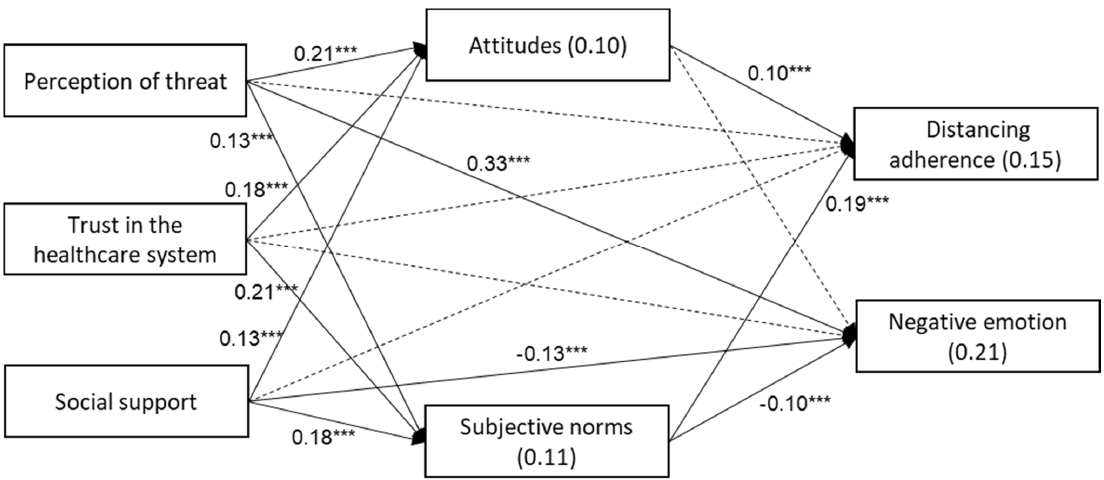
Figure 1. Path analysis for the perception of threat, trust in the healthcare system, social support, attitudes, and subjective norms towards following distancing instructions and the behavior of following social distancing and negative feelings. *** p < 0.001. Note: the control variables were excluded from the figure for purposes of clarity. Values on arrows— β values; values within the rectangles— R 2 .